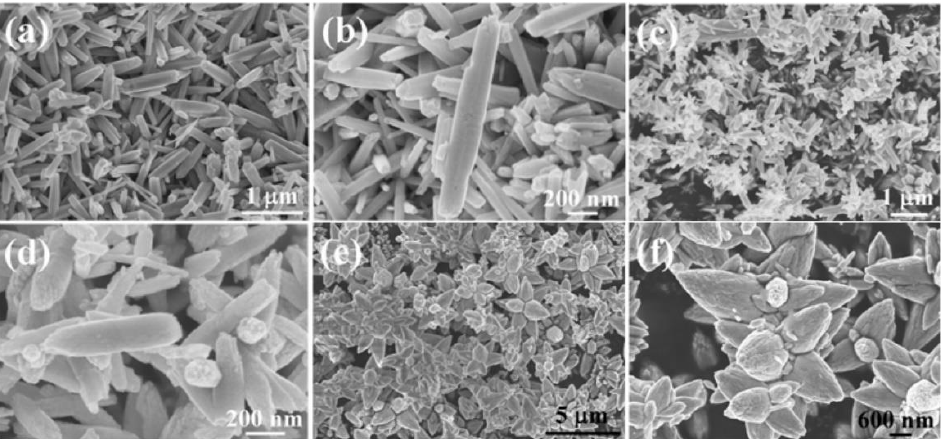
Figure 71. SEM images of ZnO products synthesised from zinc acetylacetonate hydrate with the Zn/HEPES molar ratio of 1:5 prepared under different pH values: 7.4 ( a , b ); 8.4 ( c , d ); 9.4 ( e , f ). Products synthesised by the microwave and ultrasonic wave combined method. Reprinted from [844], Copyright (2013), with permission from Elsevier [OR APPLICABLE SOCIETY COPYRIGHT OWNER]. All rights reserved. In order to re-use permission must be obtained from the